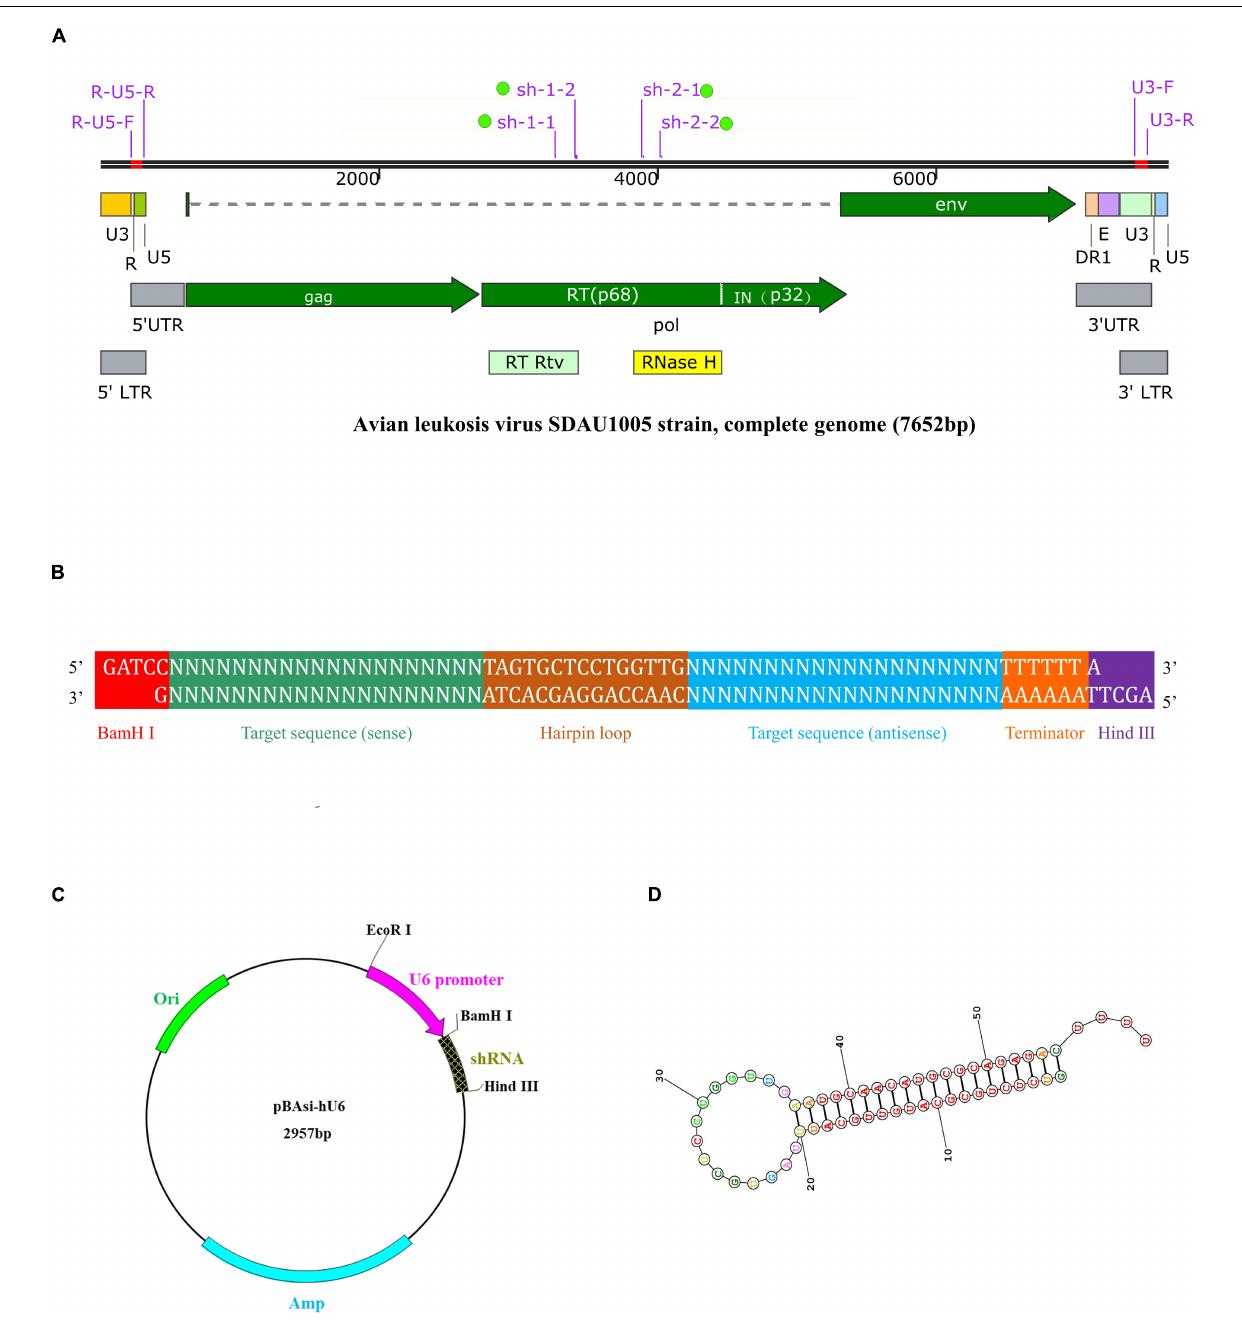
FIGURE 1 | Schematic description of target ALV genomic features, shRNA expression cassette and vector, and shRNA structure. (A) Genomic structure of ALV-J stain SDAU1005 and position of target shRNA: sh-1-1, sh-1-2, sh-2-1, and sh-2-2. (B) An inverted repeat is cloned into the shRNA expression vector. The inserted DNA is designed in the following order: BamH I restriction endonuclease site, sense sequence, hairpin loop structure, antisense sequence, termination signal, and Hind III restriction endonuclease site. The forward sequence and reserve sequence are both 67-nt long. (C) Map of the pBAsi-Hu6 shRNA expression vector. The inverted repeat is inserted into the corresponding site (BamH I/Hind III) of the vector. (D) The secondary structure of the shRNA predicted by RNA structure